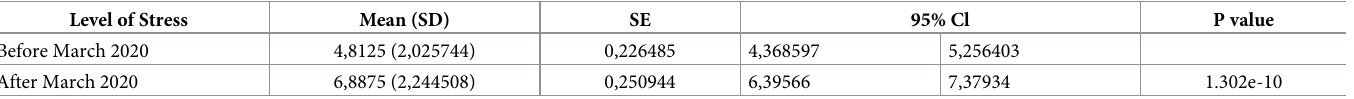
Table 2. Level of stress before March 2020 and after (Willcox test). Descriptive analysis and data quality, by a number of participant (N), mean, standard deviation (SD), standard error of the mean (SE), 95% confidence interval (95% CI). Level of